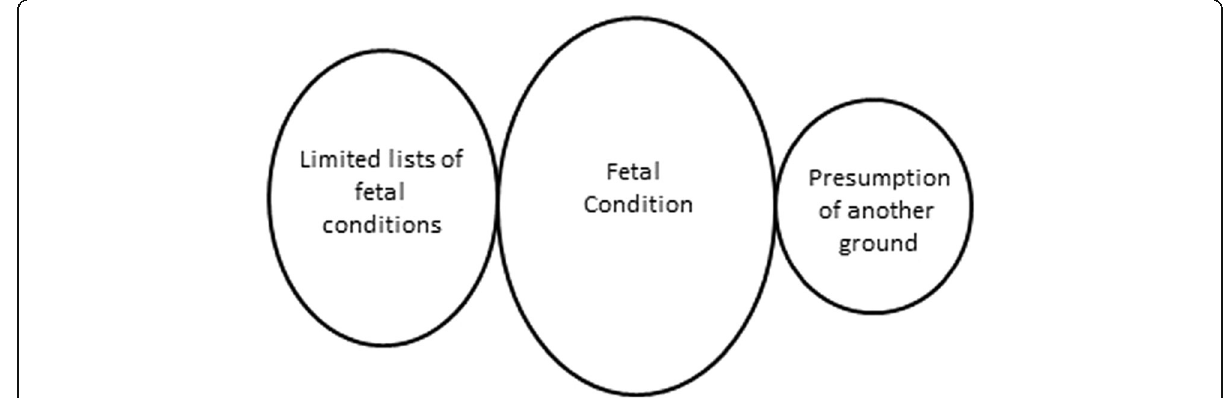
Fig. 2 Relationship between a ground based on fetal condition and related